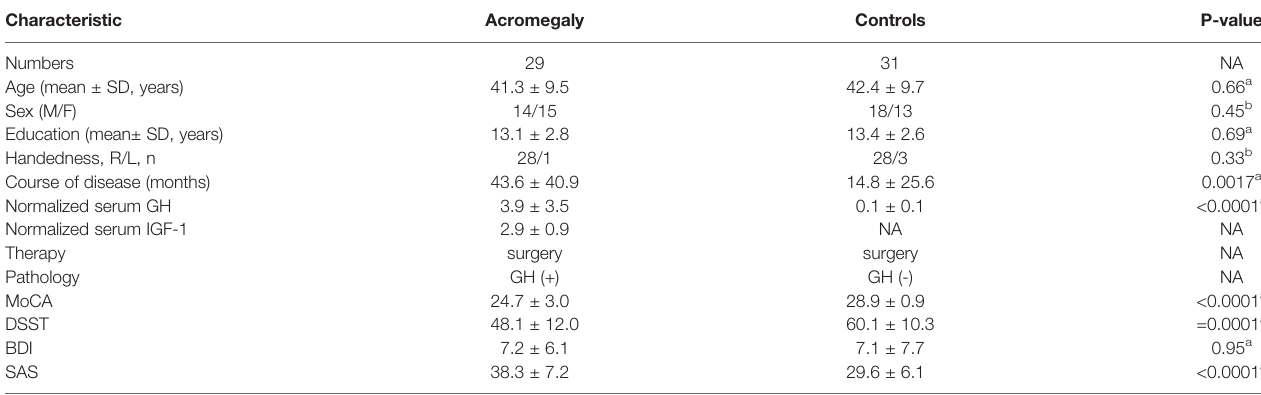
TABLE 1 | Demographic and clinical characteristics of the